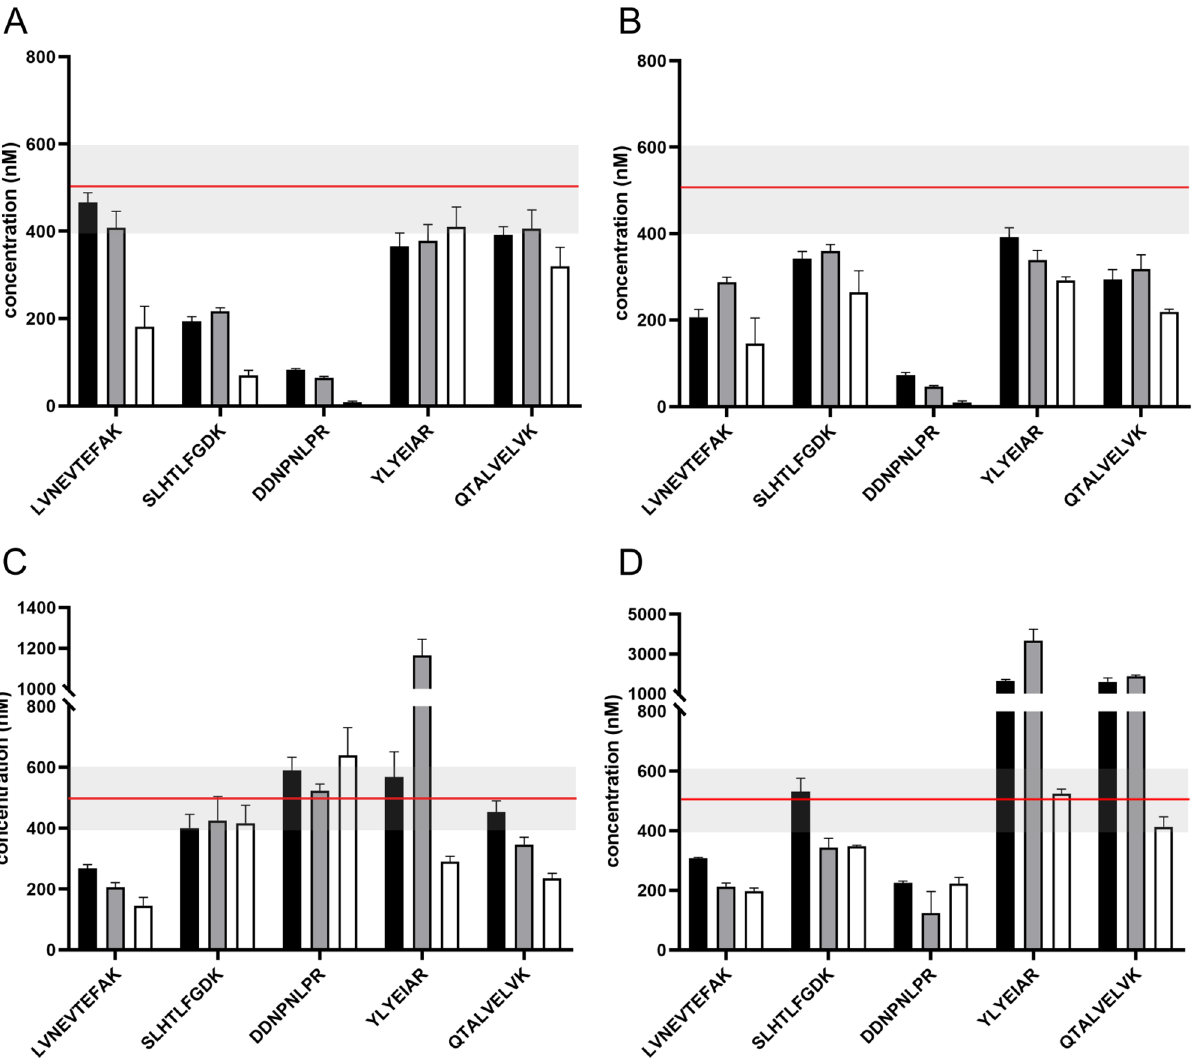
Figure 3. The effect of organic content in the reconstitution solvent on the quantitative performance of SIL-Ex peptides. HSA protein concentration was determined using SIL-TCT ( A ), SIL-ExC5 ( B ), SIL-ExC3N3 ( C ), and SIL-ExC5N5 ( D ) peptides reconstituted in AmBic/SDC buffer with 5% (black), 20% (grey), and 50% ACN (white). HSA concentration determined by reference methods (500 nM) indicated as a red line; the grey area represents 20%